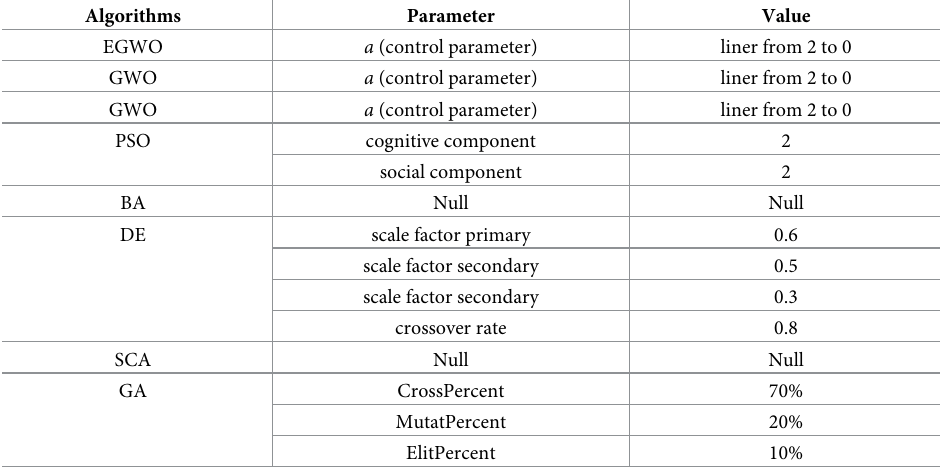
Table 2. List of parameter setting used